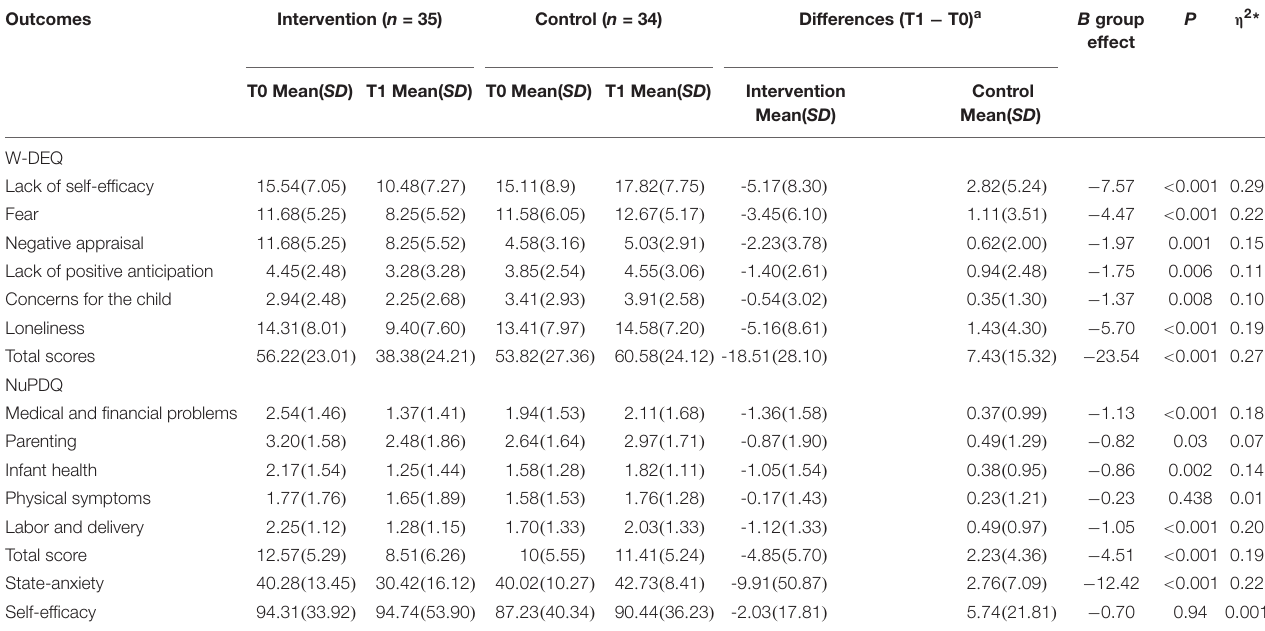
TABLE 3 | Between-group differences at post-treatment (T1) and pre-treatment (T0) and effect sizes for assessments. Outcomes Intervention ( n =